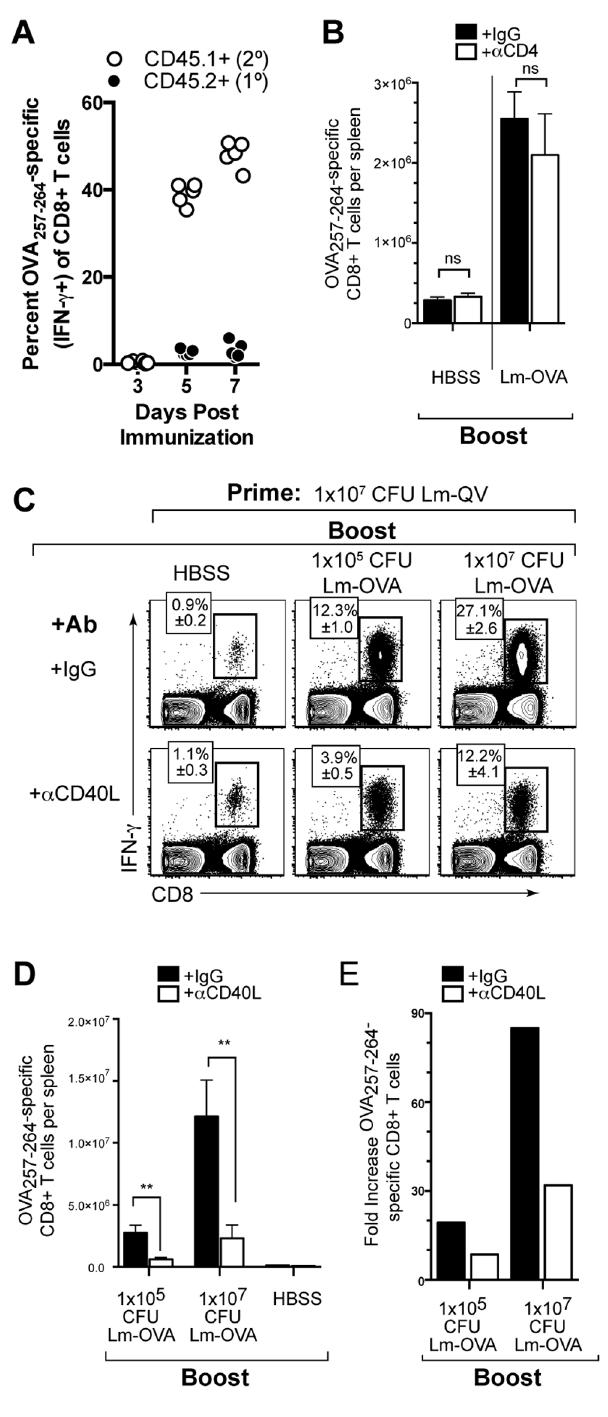
Figure 1. Memory CD8 + T cell expansion following homolo- gous boost is CD4 + T cell independent but CD40L dependent. Mice primed with Lm-OVA were boosted 21 days later with the indicated dose of Lm-OVA. 5 days post-boost, OVA 257–264 -specific CD8 + T cells were enumerated by IFN- c intracellular cytokine staining. (A) CD8 + splenocytes were transferred from Lm-OVA primed B6.SJL (CD45.1 + ) mice into C57BL/6 (CD45.2 + ) recipients. Recipient mice were then treated with Lm-OVA and the frequency OVA 257–264 -specific CD8 + T cells was determined by intracellular IFN- c staining. (B) Mice were depleted of CD4 + cells at the time of the secondary immunization. Absolute OVA 257–264 -specific CD8 + T cells five days post homologous Lm-OVA prime-boost (mean 6 SEM, n =5). (C-E) Mice were treated